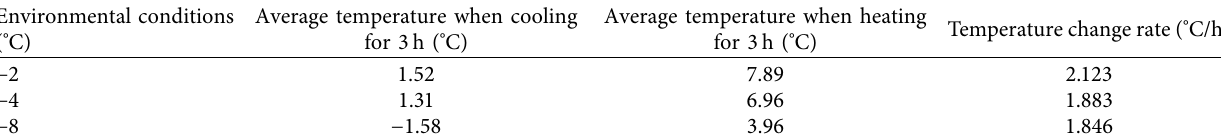
Table 4: Temperature change rate of the first layer’s measuring points Nos. 4, 5, and 6 of the temperature rise experiment. Environmental